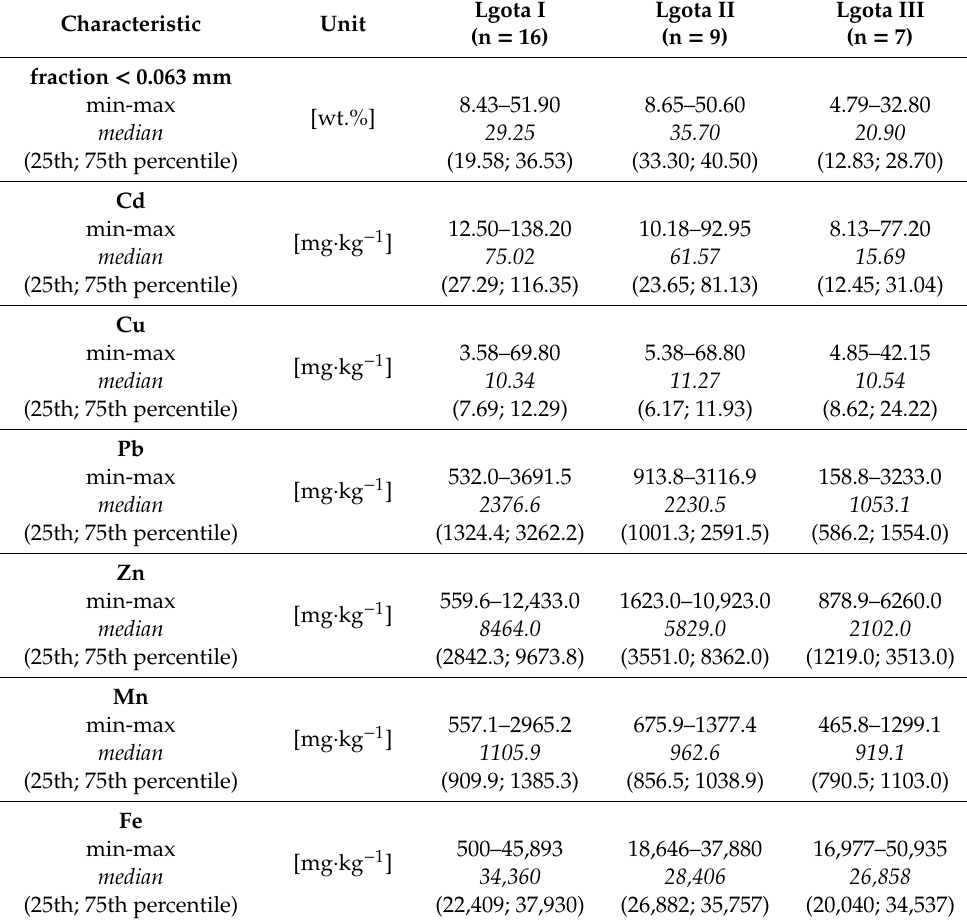
Table 3. Metals and silty-clay fraction concentration in the soil from profiles at the Lgota location.